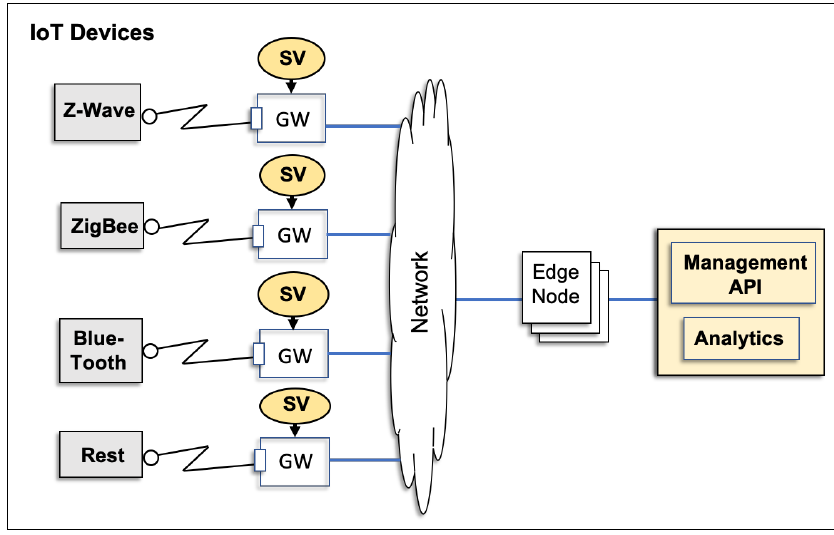
Figure 1. IoT nodes and their